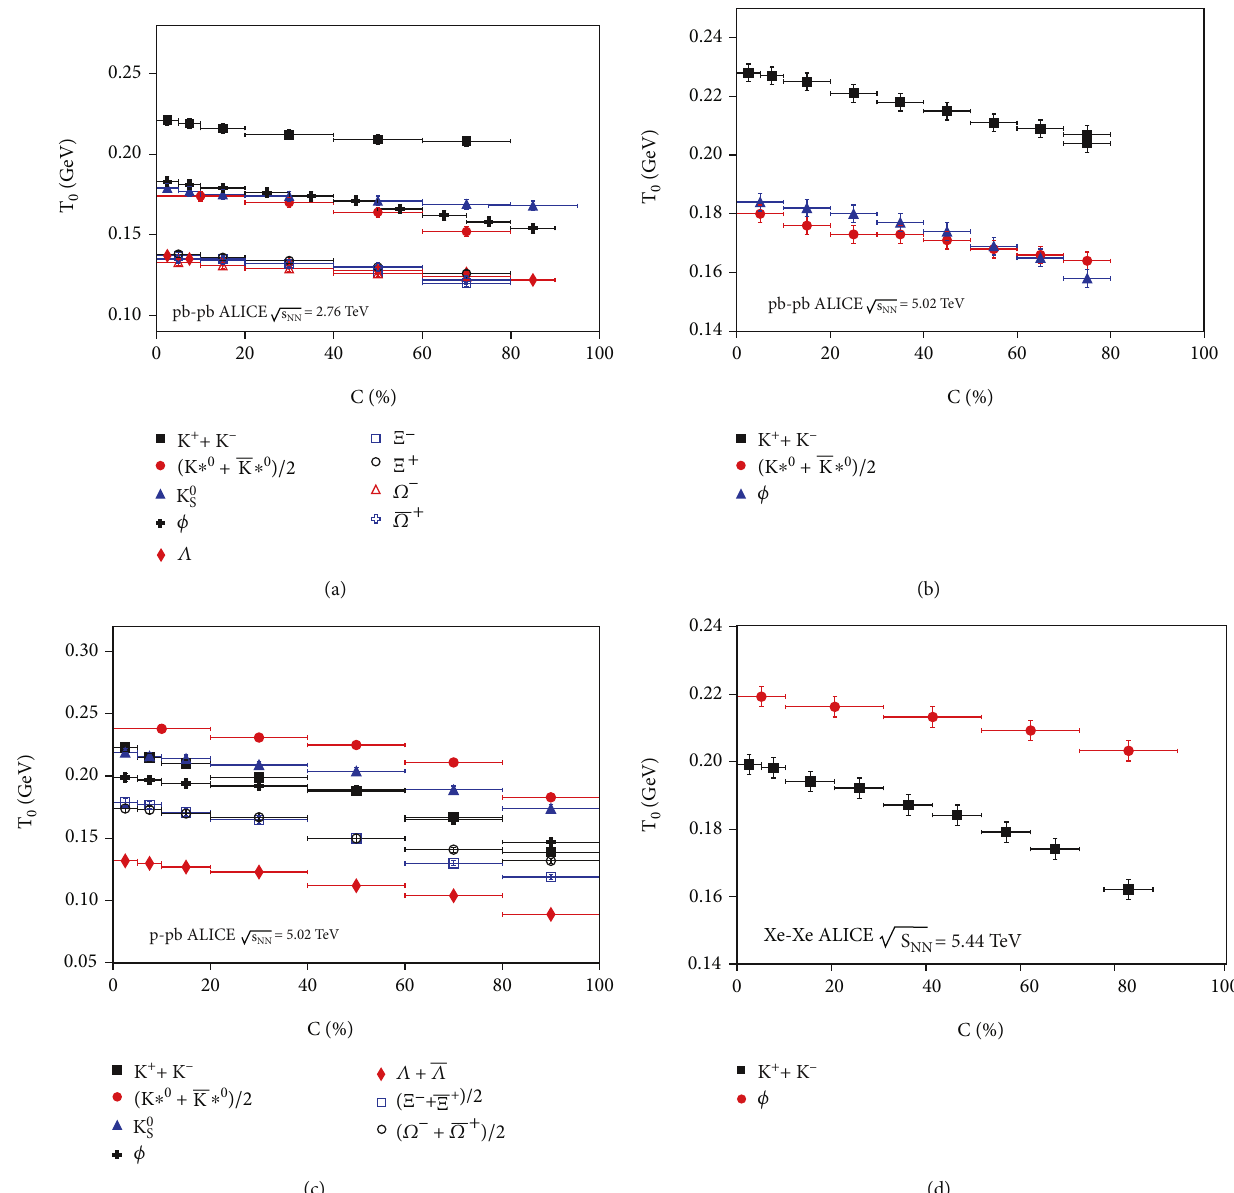
C in Pb – Pb, (c) p – Pb, and (d) Xe – Xe 0 on centrality and